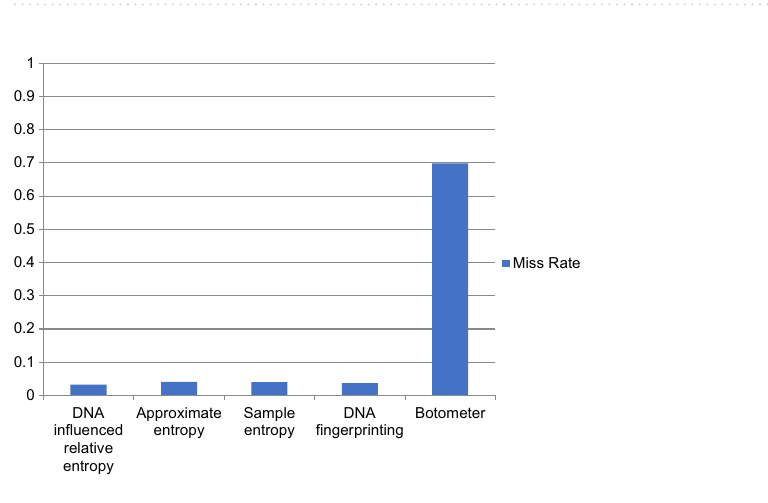
Figure 5. Comparison of Miss rate metric for different state-of-art approaches.